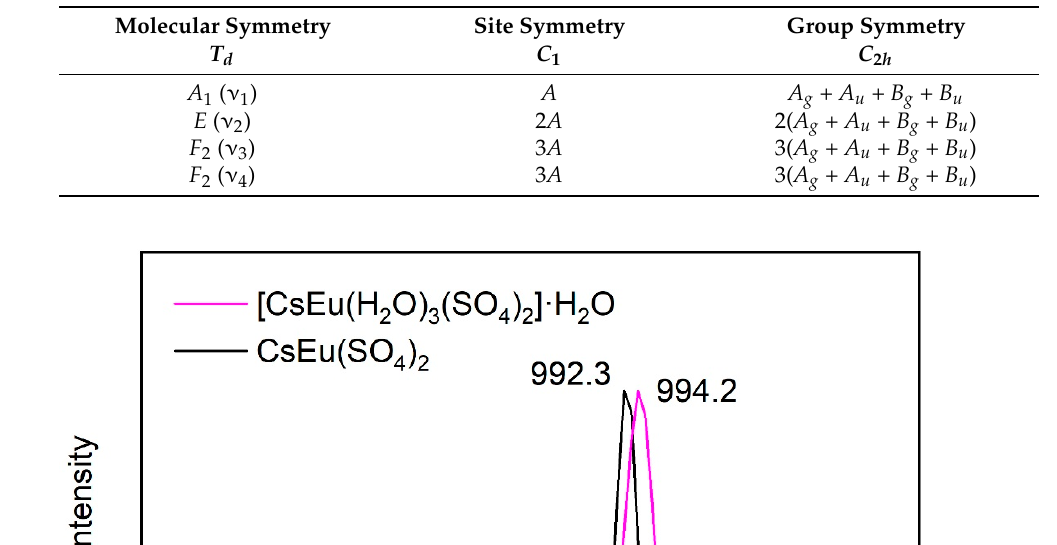
Table 2. Correlation between molecular symmetry, site symmetry and factor group symmetry for